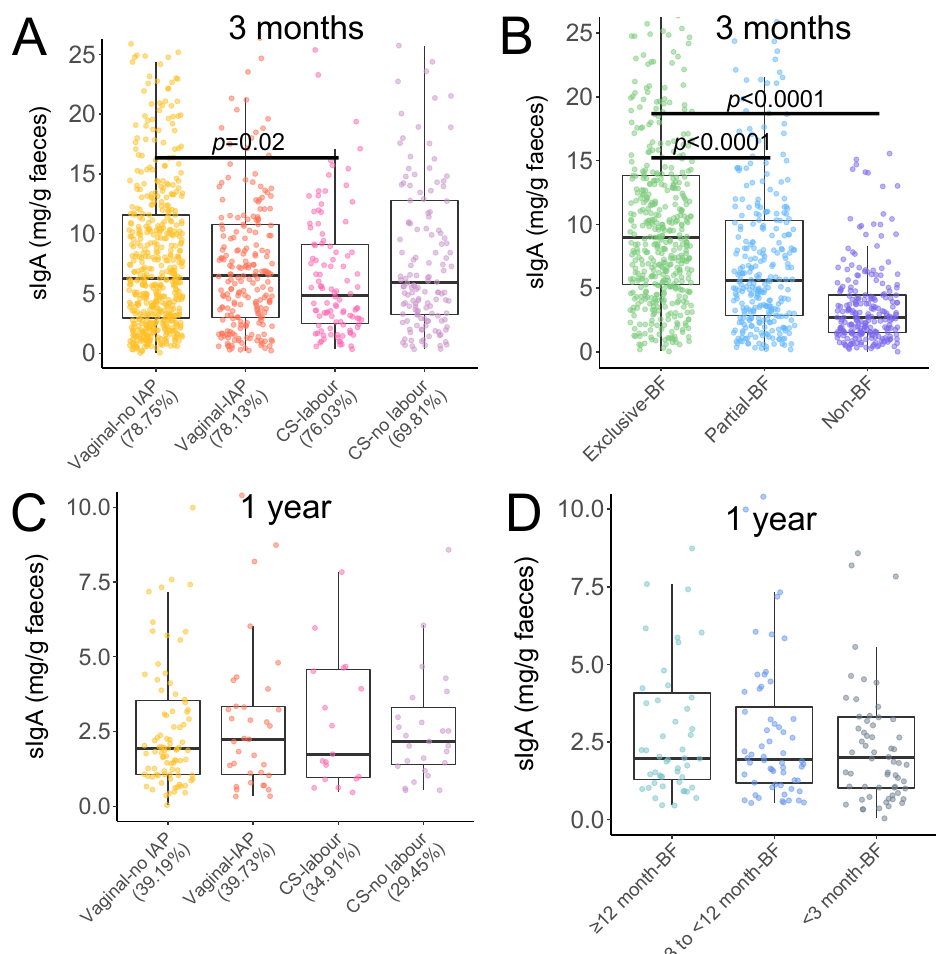
Figure 1. Infant fecal SIgA concentrations according to birth events ( A , C ) and breastfeeding status ( B , D ) at 3 months and 1 year. Following different birth event, the percentage of infants who were breastfed at 3 months ( A ) and those who were breastfed greater than or equal to 12 months at 1 year ( C ) are shown in the brackets. Significant differences were determined using crude linear regression model of the Box-Cox transformed values. Vaginally delivery without IAP exposure and exclusive breastfeeding are reference